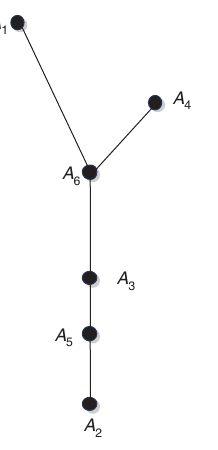
Figure 9. The MST of the Fuzzy Graph G = ( V , E ).